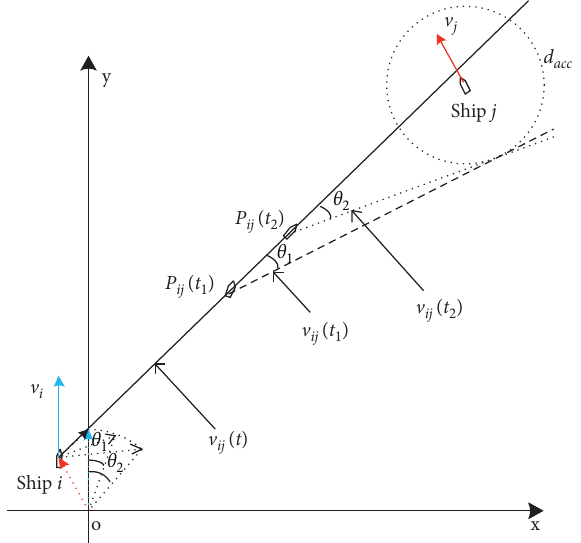
Figure 2: A sample of the autonomous vessel (own ship) en- countered with a manned vessel (target